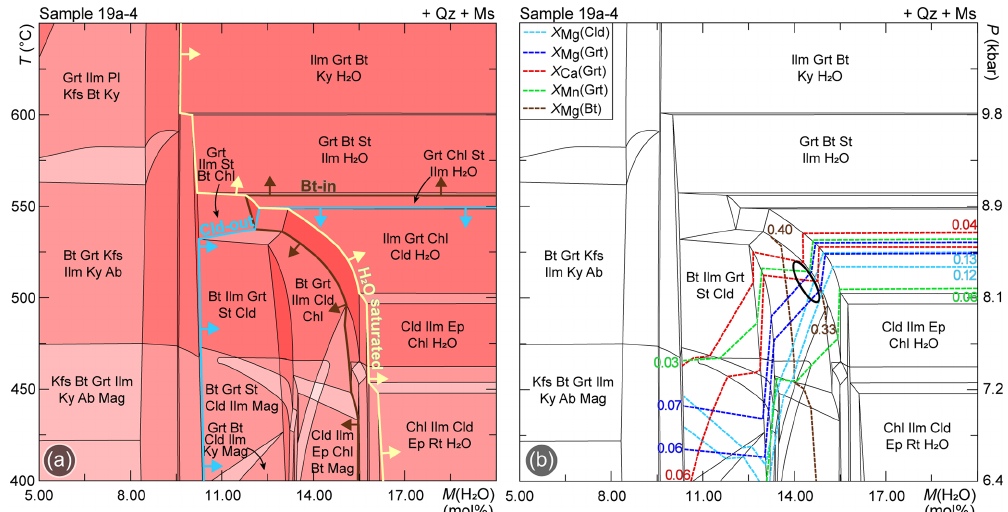
Figure 8. (a) P / T – M (H 2 O) phase diagram modelled for sample 19a-4, along the thermobaric gradient reported in Fig. 1c. The chloritoid- out and the biotite-in reaction curves are highlighted in light blue and brown, respectively. The yellow line separates H 2 O-saturated from H 2 O-undersaturated conditions. (b) Compositional isopleths for chloritoid, garnet and biotite plotted for sample 19a-4. The black ellipse shows the constrained conditions based on the intersection of compositional isopleths. See Fig. S5 for sample 19a-2a.